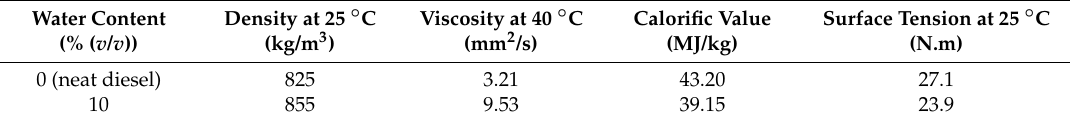
Table 1. Properties of neat diesel and water-in-diesel